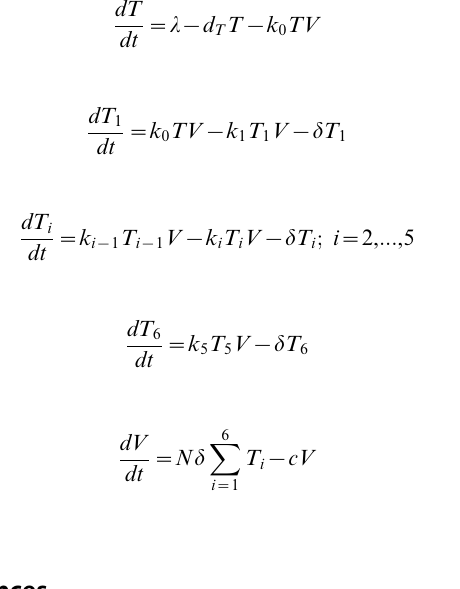
n = 3 is analogous to the Hill coefficient (Fig. 10). We also perform simulations with a multiplicative fitness landscape, where f i ~ exp( { sd iF L ) with s the fitness penalty per mutation.